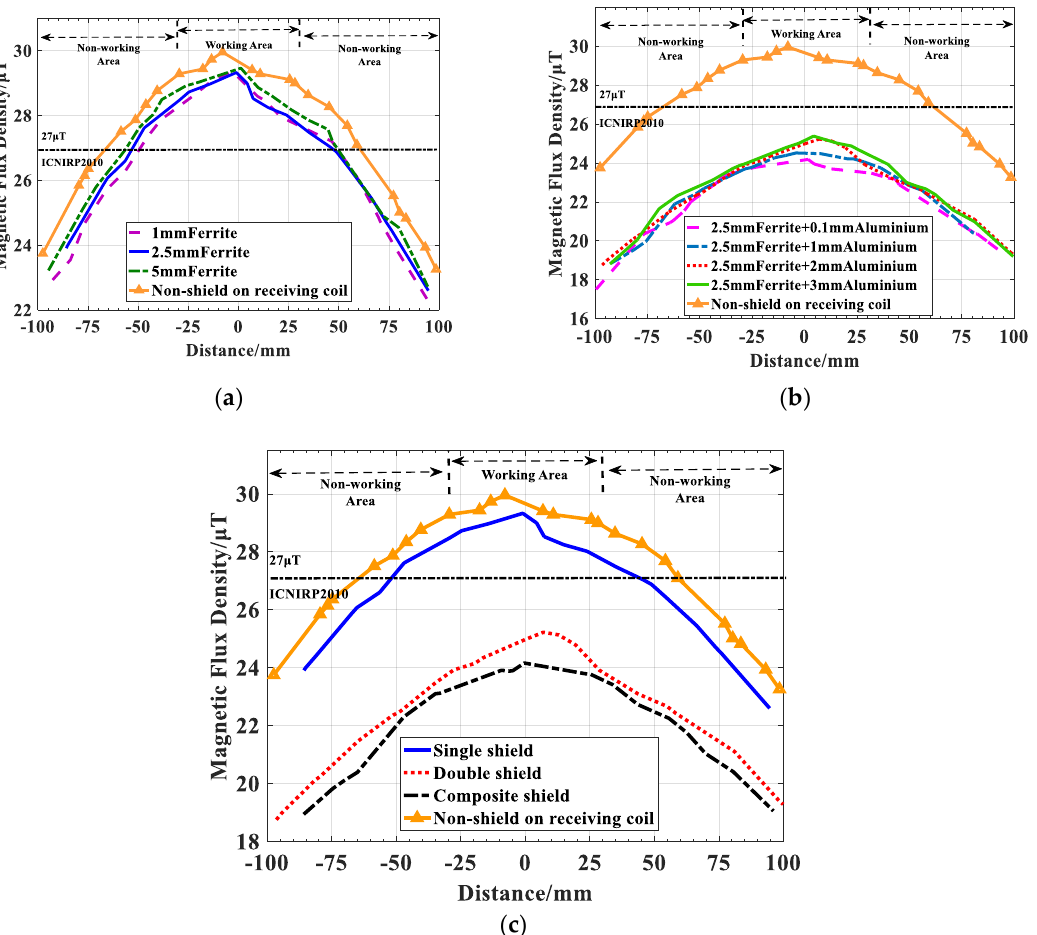
Figure 9. Magnetic flux density versus simulated measurement position at axial 250 mm outside the magnetic coupler. ( a ) Single shield magnetic coupler with different ferrite thickness. ( b ) Double shield magnetic coupler with different aluminum thickness. ( c ) Comparison of different shielding types.